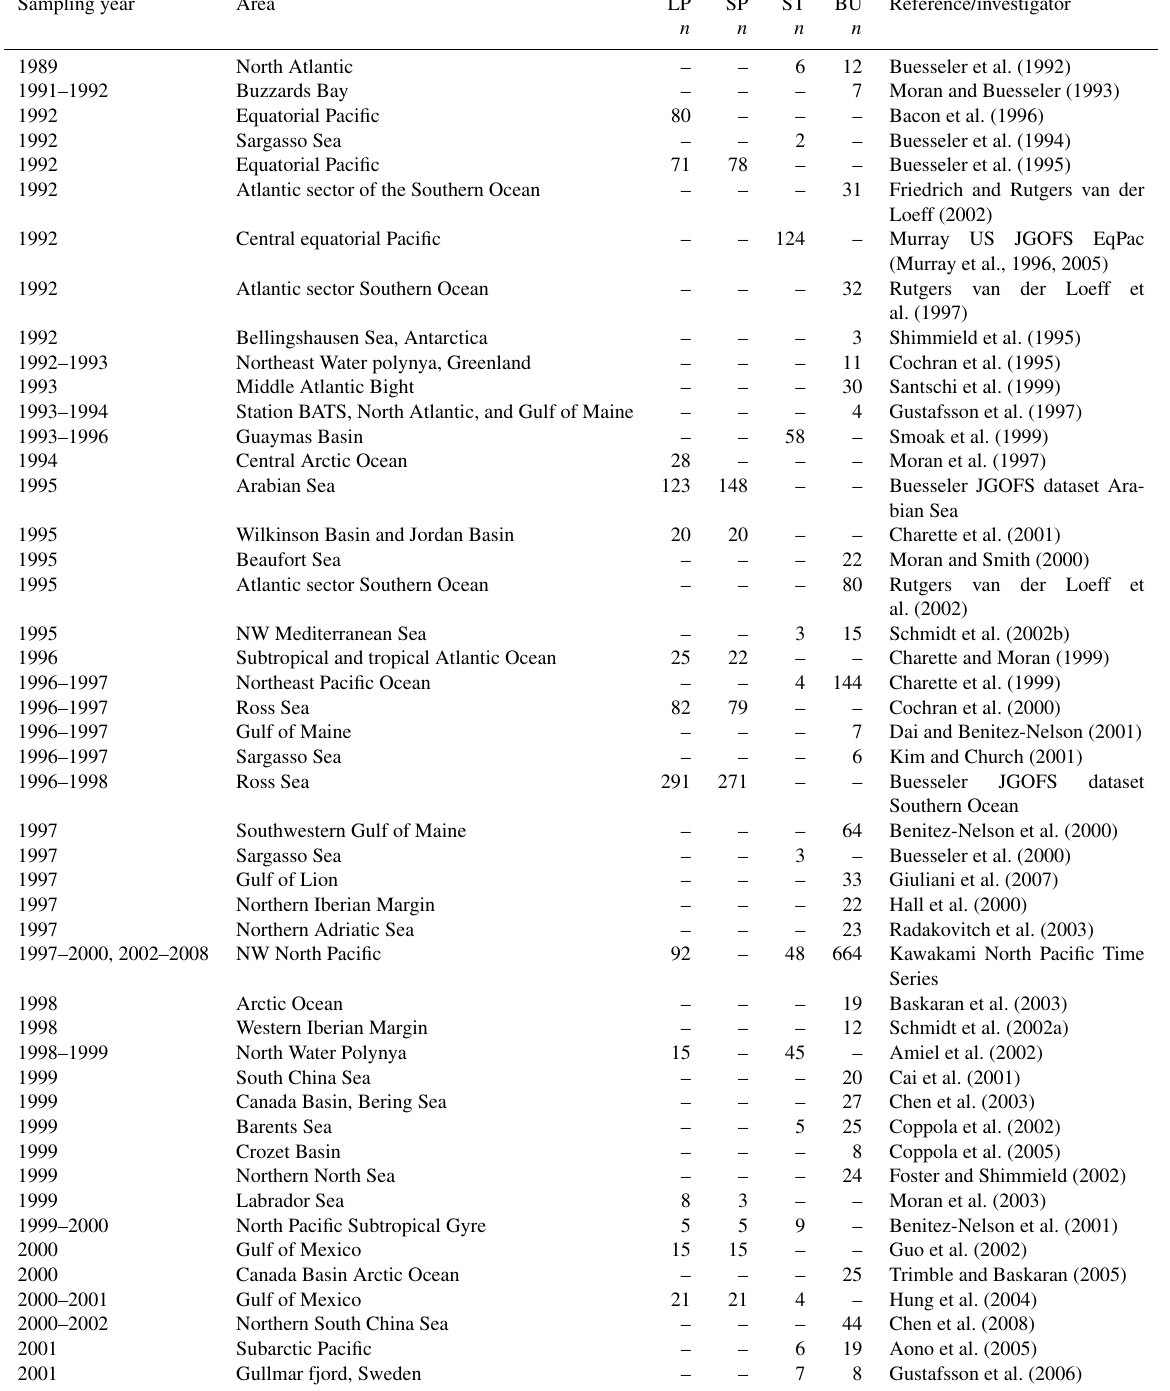
Table 1. Sampling year; area; number of samples for large particles (LPs), small particles (SPs), bulk (BU) particles, and particles collected with sediment traps (STs); and reference of studies used in the database. Note the following references refer to data published in several papers: Stukel et al. CCE refers to data published in Stukel et al. (2011, 2015, 2017, 2019); Stukel et al. CRD refers to data from Stukel et al. (2015, 2016). Buesseler JGOFS dataset Arabian Sea refers to data published in Buesseler et al. (1998) and also available at